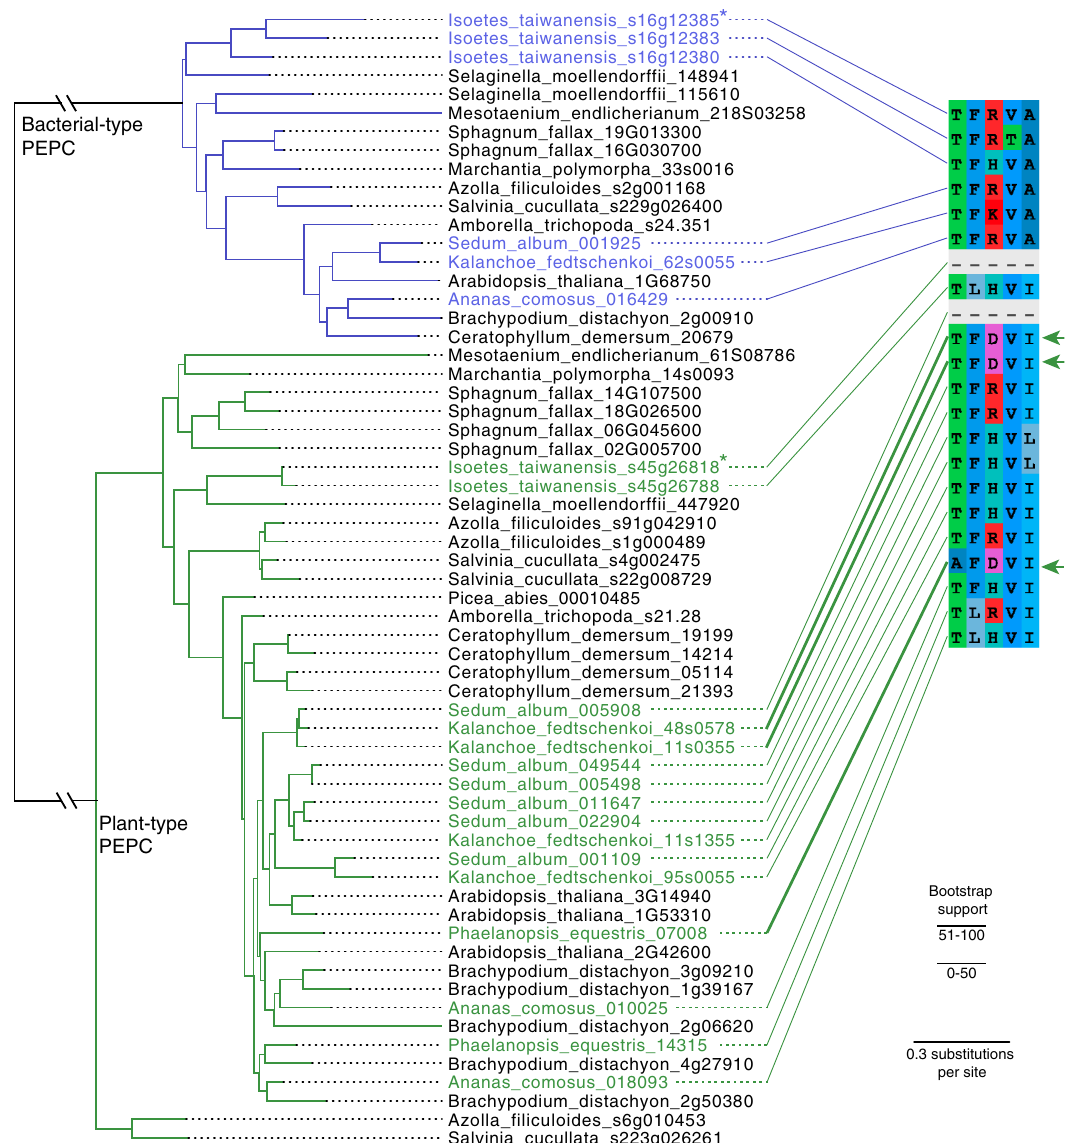
Fig. 4 A lack of PEPC sequence convergence in I. taiwanensis . Copies with putative convergent amino acid sequence (D at position 3 in alignment) are indicated by thickened connecting lines and green arrows. Copies of bacterial-type and plant-type PEPC shown to cycle in I. taiwanensis are marked with asterisks (*). Branch thickness indicates bootstrap